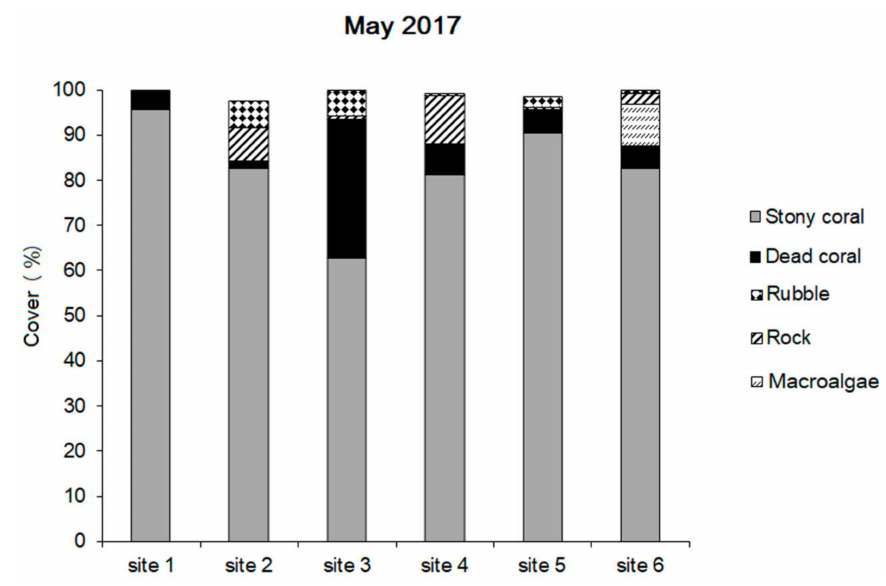
Figure 5. Distribution of the major benthic categories at 6 sites surveyed in May 2017. Table 2. Results of one-way ANOVA for temporal differences in major categories and dominant taxa at three study